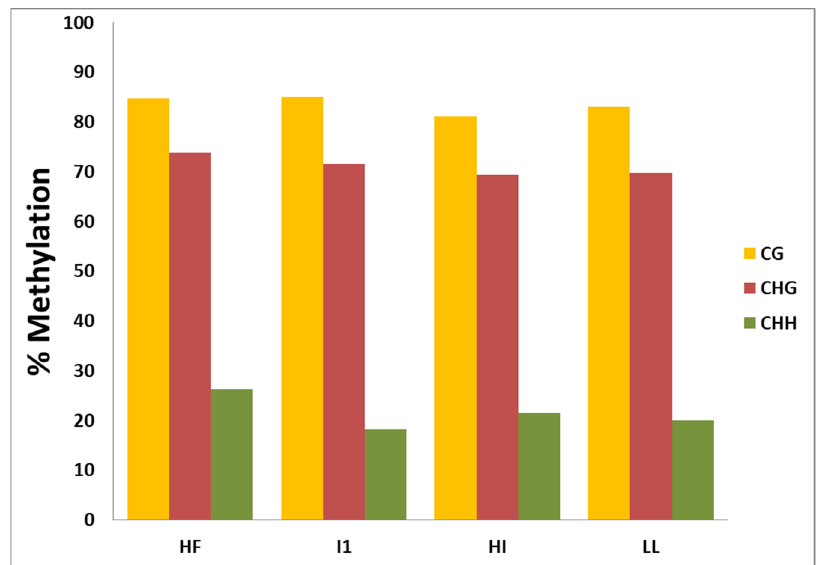
CHH methylation level in HF (26.26%) was significantly higher than that in I1 (18.22%) (Figure 3).